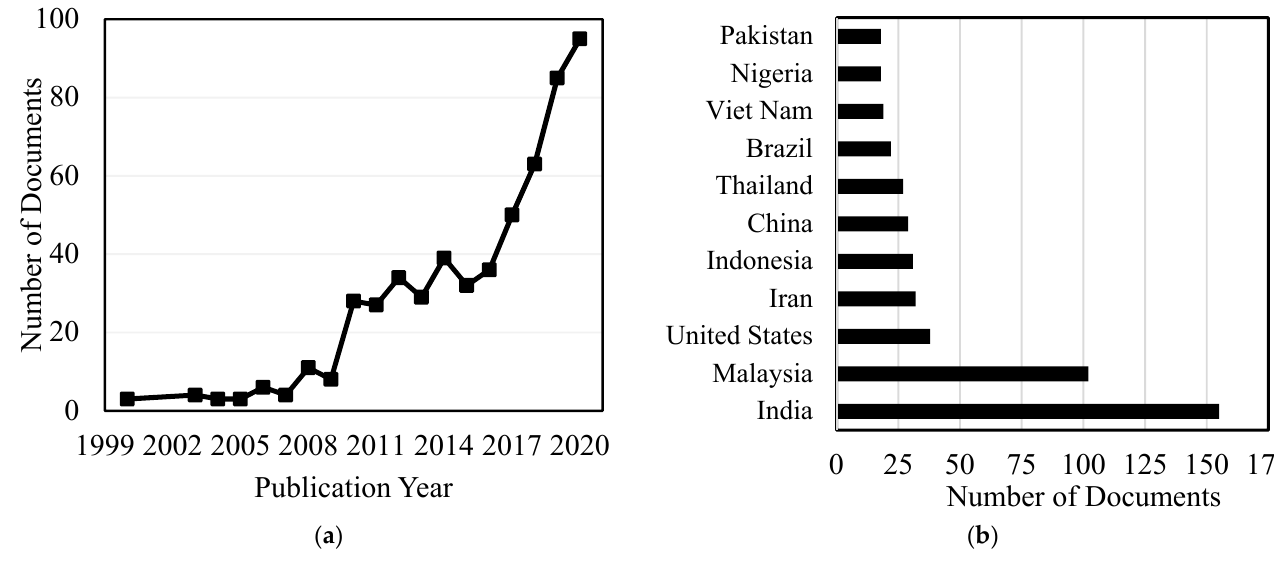
Figure 2. Research conducted on RHA: ( a ) during last two decades, and ( b ) by different agricultural countries (source: Scopus, date of accessing data: 25 May, 2021).